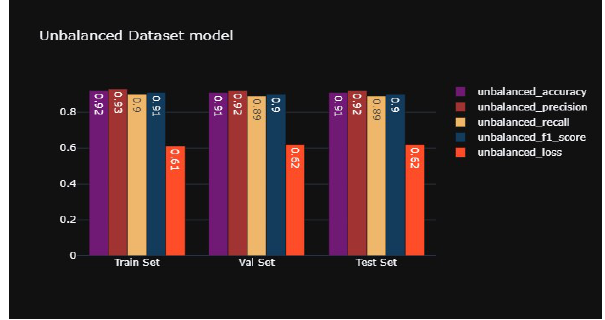
Fig. 8. Unbalanced dataset model performance